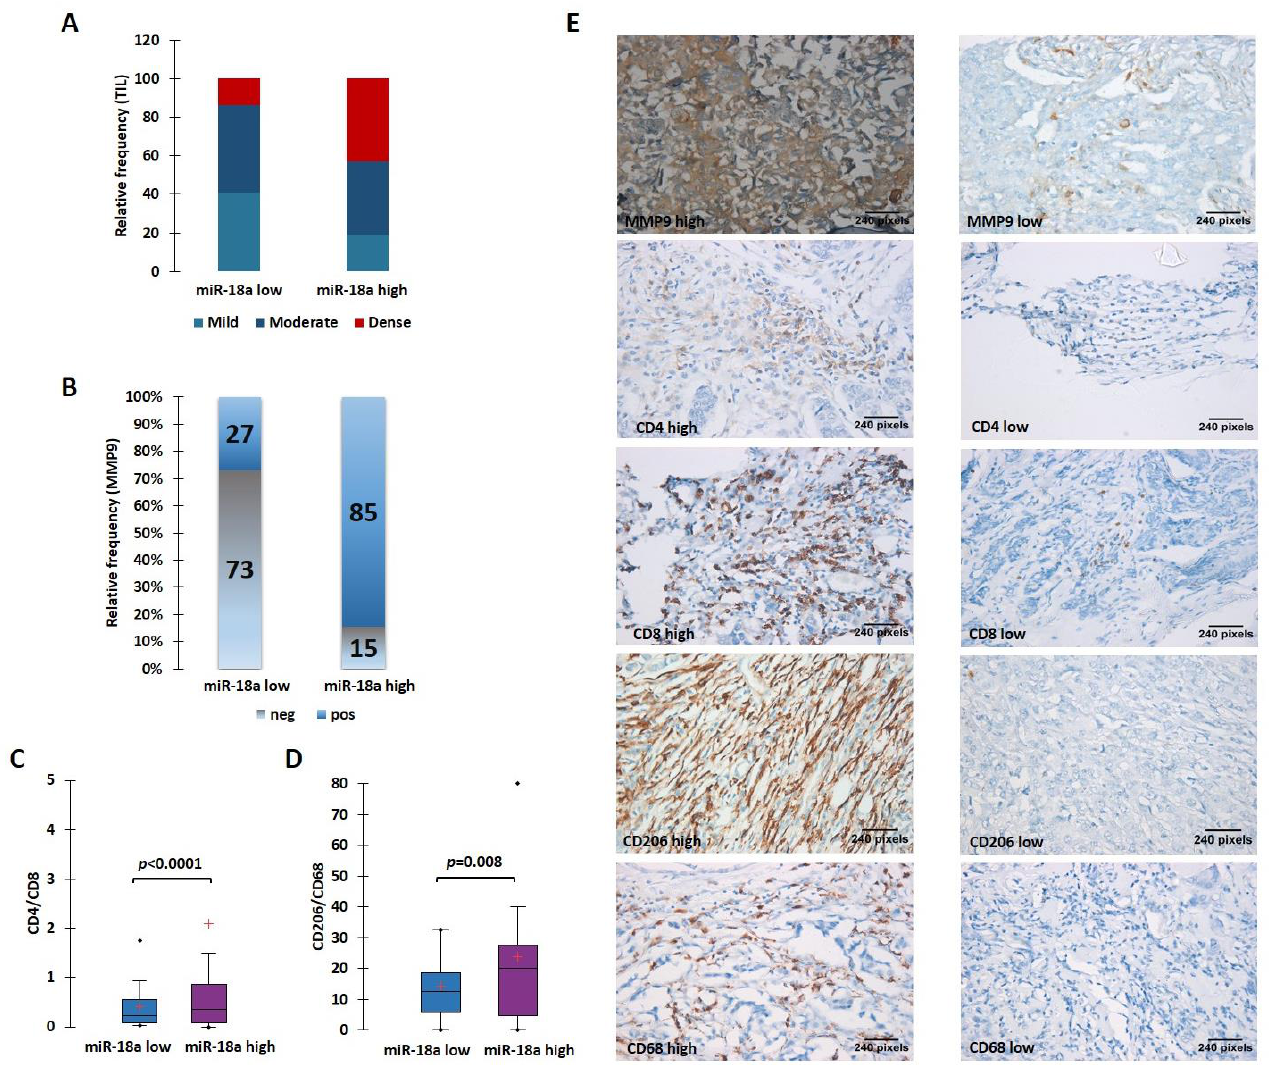
Figure 4. High levels of miR-18a in ER-positive tumor specimens correlate with a protein expression suggestive of an immunosuppressive ECM. ( A ) TIL density in ER+ miR-18a low and high tumors. ( B ) Expression levels of MMP9 in miR-18a low and high expressing tumors. ( C ) Association of CD4/CD8 in ER+ tumor groups segregated based on upper and lower quartiles of miR-18a expres- sion. ( D ) Association of CD206/CD68 in ER+ tumor groups segregated based on upper and lower quartiles of miR-18a. ( E ) Representative images of MMP9, CD4, CD8, CD206, and CD68 stained sections. Statistical analysis was performed using two-sample comparison of variance test. p < 0.05 is considered significant. ‘+’ indicates mean and ‘∙’ indicates outlier.